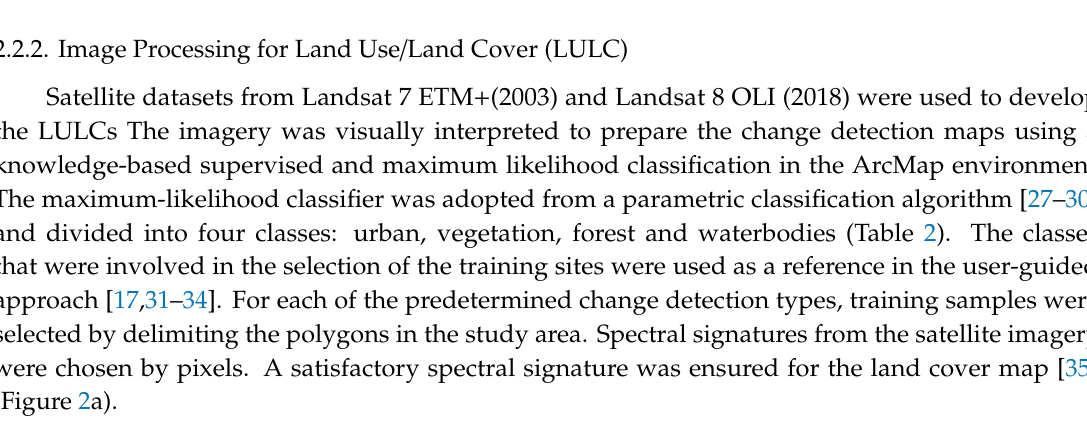
Table 2. Selected features for supervised classification in Land Use / Land Cover (LULC)